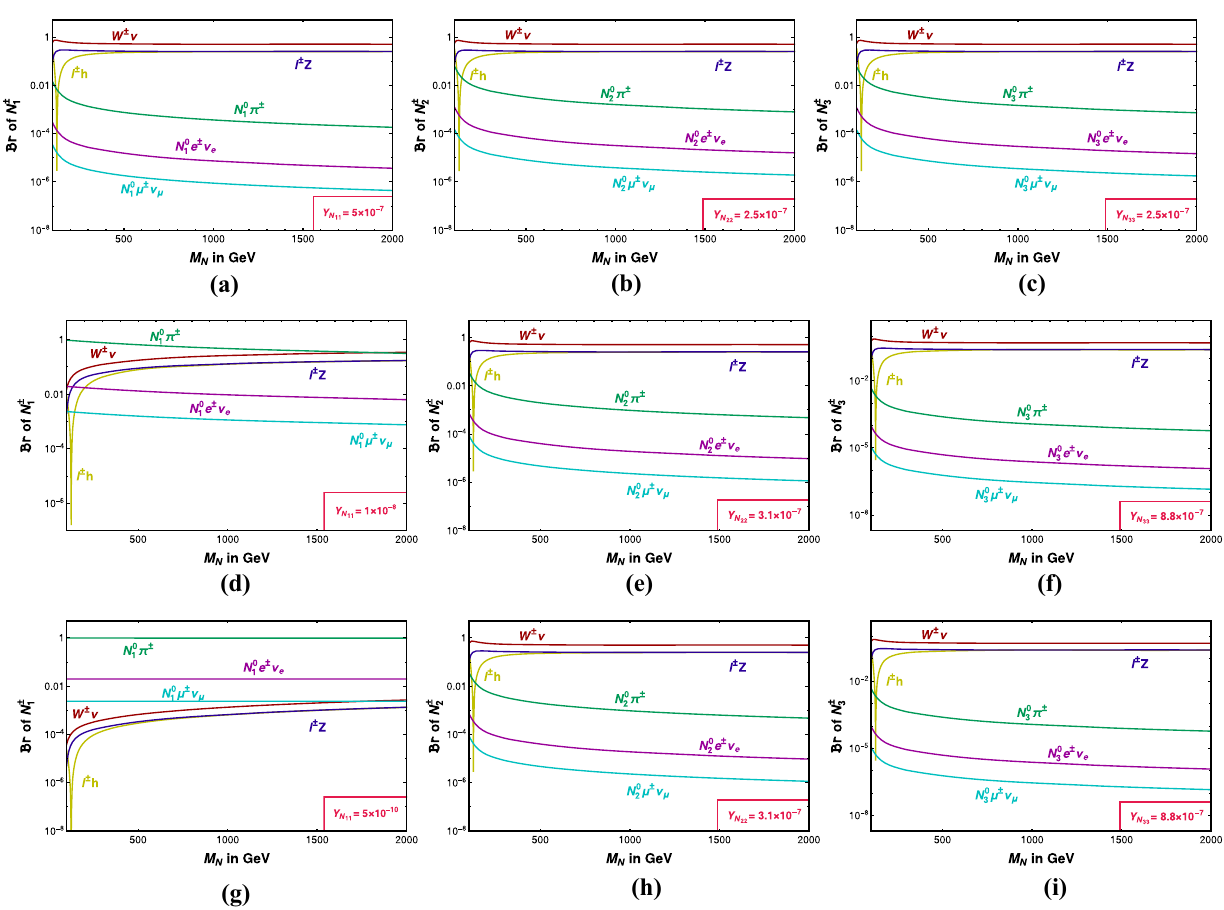
Fig. 2 Charged SU ( 2 ) L triplet heavy fermion ( N ± ) branching ratios to different decay channels as function of the triplet mass. Column wise we depict the branching ratios of N ± , N ± and N ± , respectively for the different choices of Yukawa couplings satisfying light neutrino masses and 1 2 3 UPMNS mixing